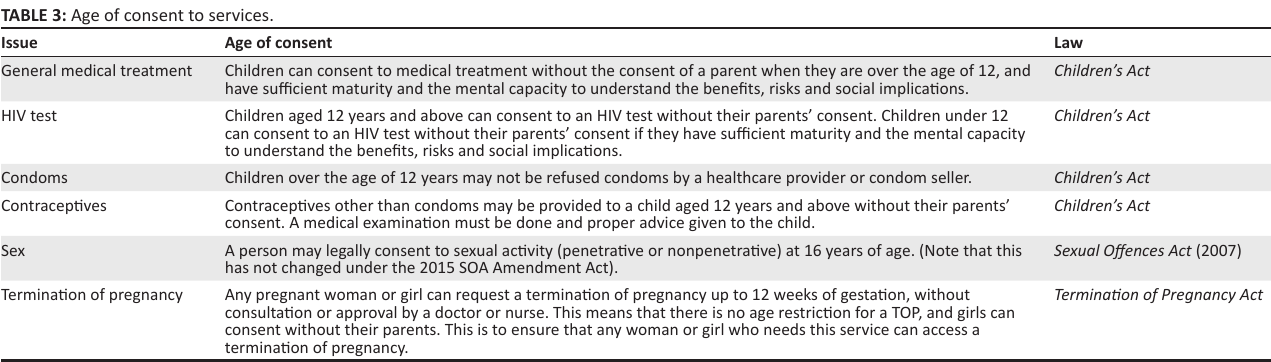
TABLE 3: Age of consent to